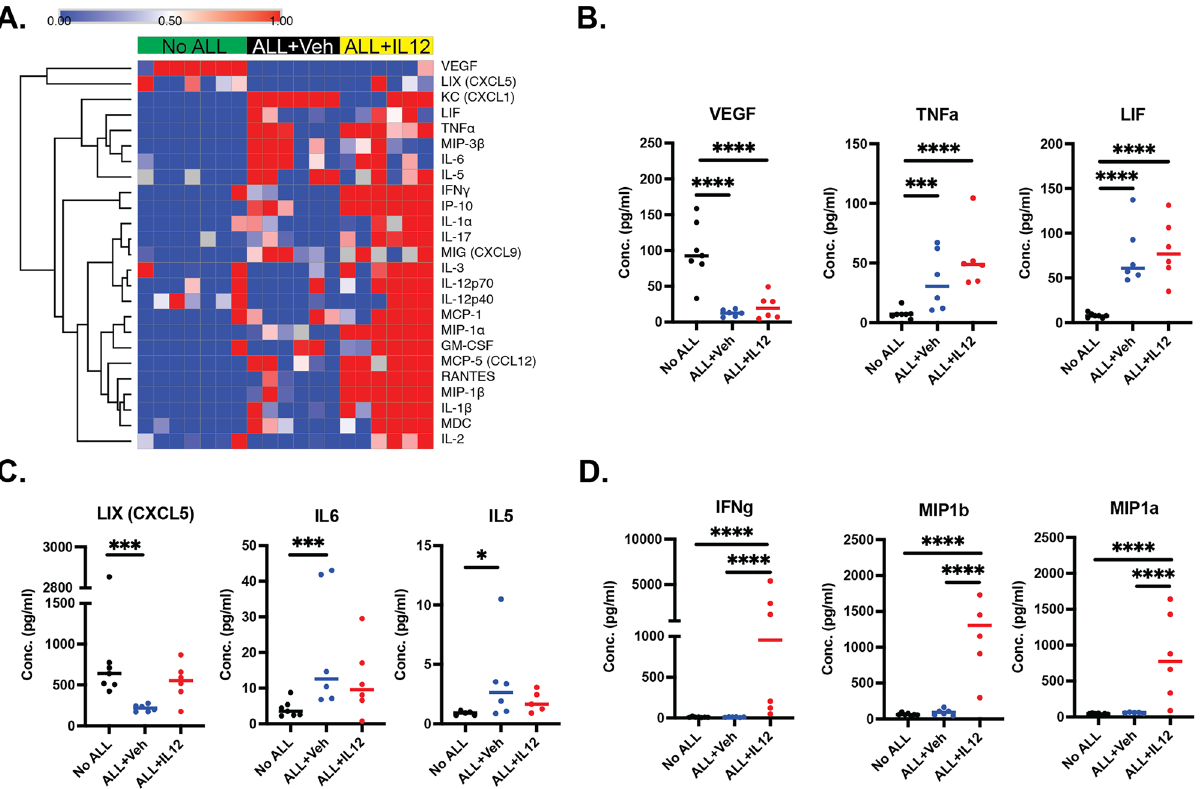
Figure 4. IL-12 treatment of B-ALL bearing mice creates an immunostimulatory soluble milieu in the bone marrow. ( A ) Luminex assay was used to measure cytokines and chemokines levels in the bone marrow of control and rIL-12 treated WT mice at day 7 ( n = 6 mice/group). The heatmap shows concentrations relative to the median with supervised hierarchical clustering by treatment condition. ( B ) Cytokines with altered concentrations attributed to leukemia. ( C ) Cytokines/chemokines with altered concentrations due to leukemia and normalized with IL-12. ( D ) Cytokines/chemokines altered due to IL-12. (* P < 0.05; ** P < 0.01; **** P < 0.0001, ANOVA with Tukey multiple comparisons